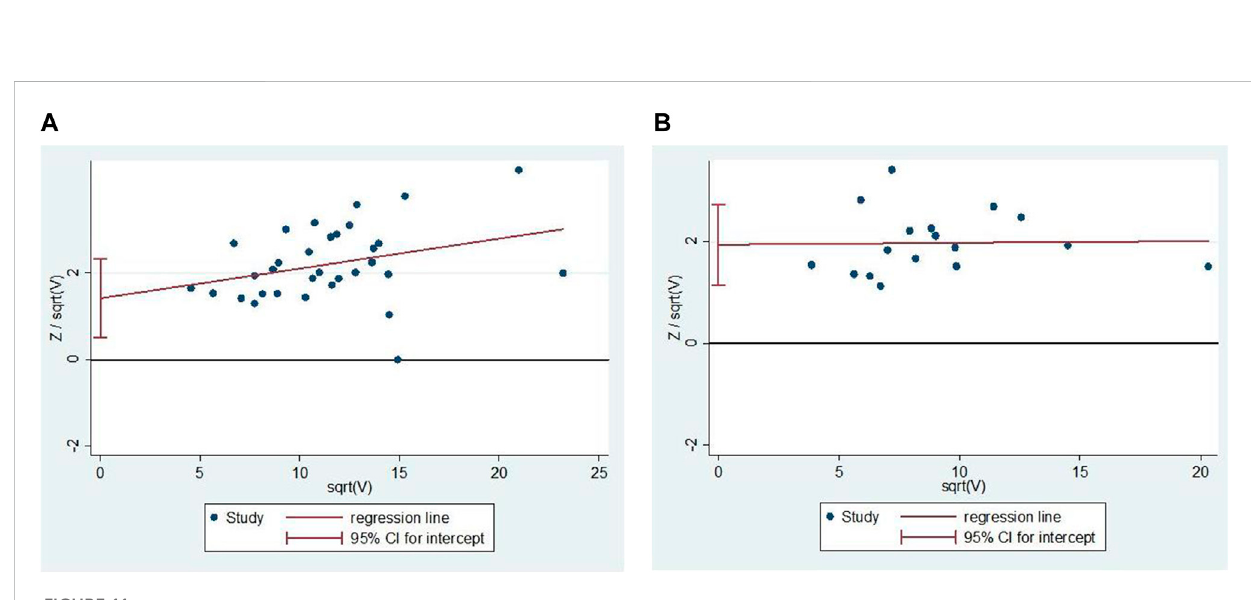
FIGURE 11 Publication bias. (A) The Harbord ’ s test on comprehensive clinical ef fi cacy. (B) The Harbord ’ s test on ECG